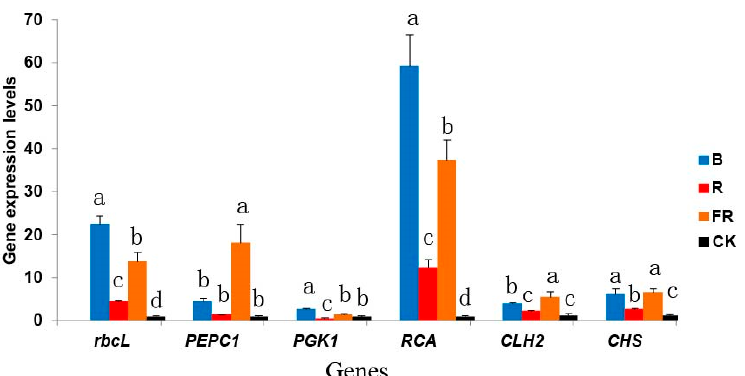
Figure 5. The expression levels of the photosynthesis-related genes in the needles of Norway spruce seedlings that were grown under four different light spectra: blue (B), red (R), far-red light (FR), and a combination of B, R and FR lights (CK).